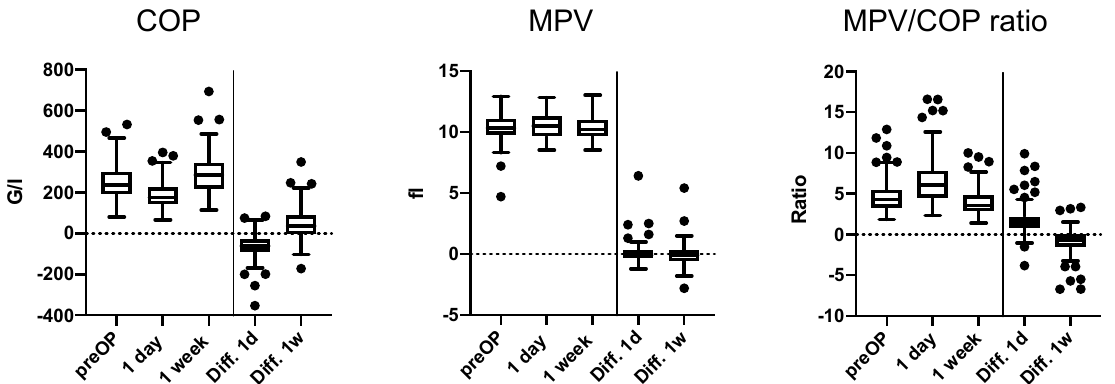
Figure 1. Tukey boxplots for pre and postoperative platelet indices and the di ff erences in perioperative platelet count (COP), mean platelet volume (MPV) and the MPV / COP ratio on 1 day and 1 week post-op compared to the pre-operative measurements.